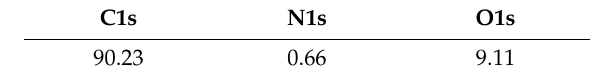
Table 1. The mean atomic concentrations of FLG nanosheets were measured 3 times by XPS.